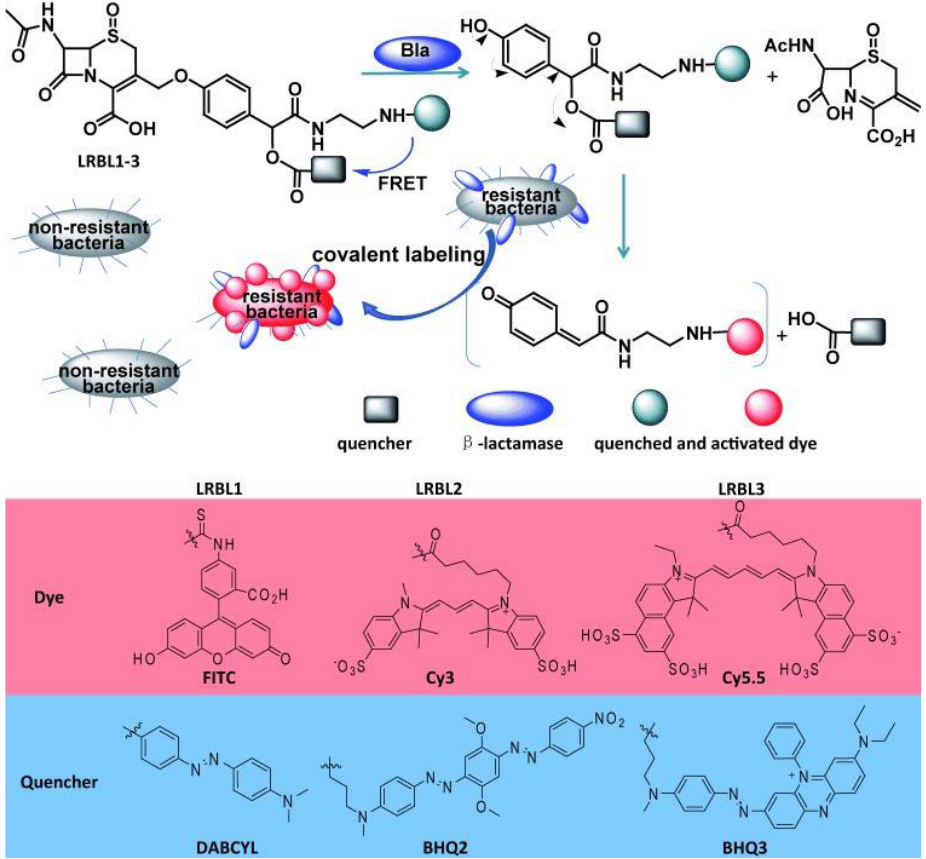
Figure 18. Activation of probes LRBL1, LRBL2, and LRBL3 by antiobiotic-resistant bacteria and applied fluorophores and quenchers. Reproduced with permission from [75], copyright 2013 John Wiley and Sons.